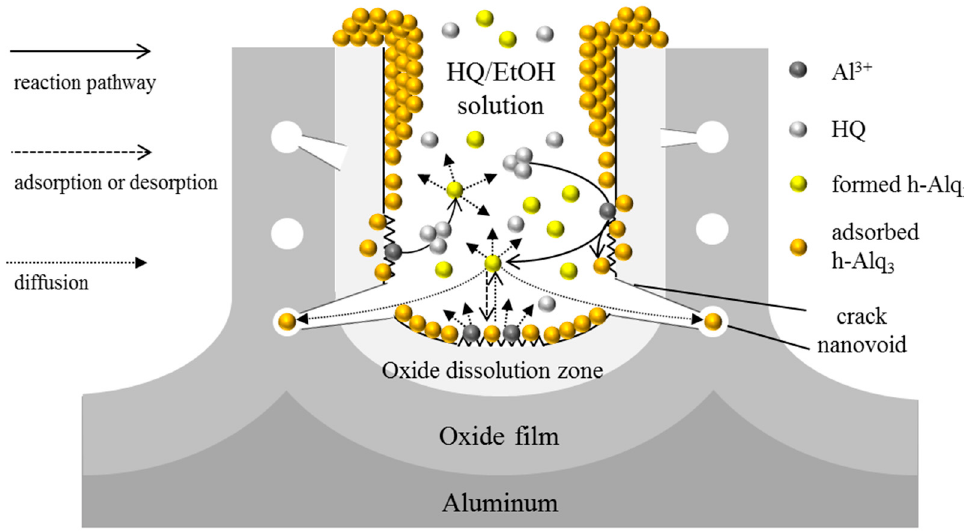
Figure 12. Formation of Alq 3 species inside the APA nanopores.